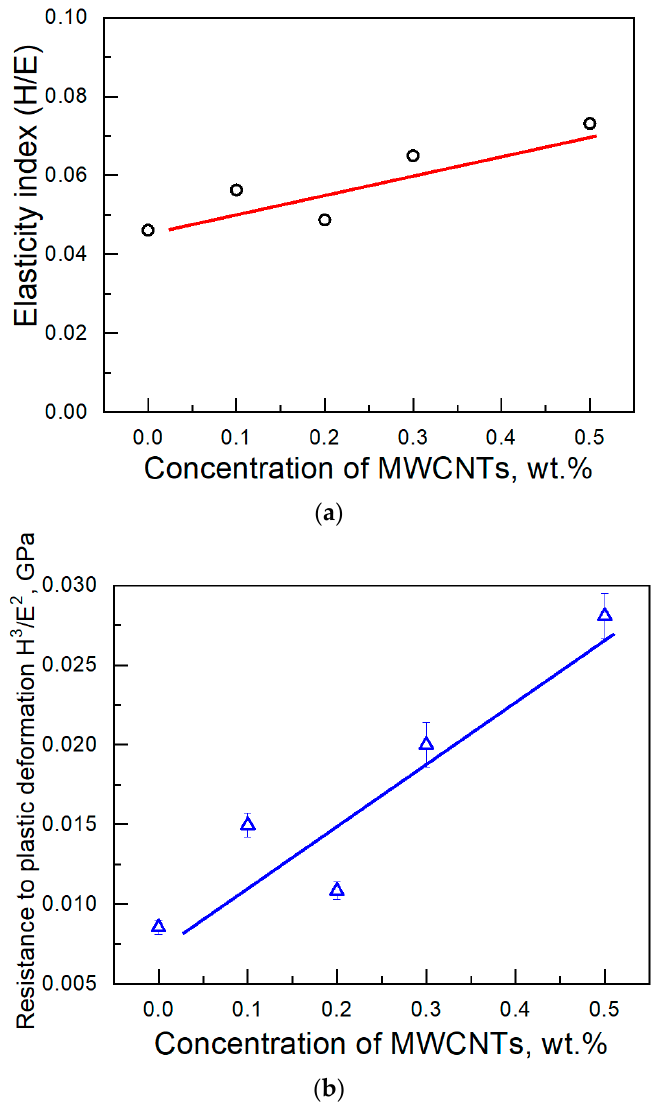
Figure 8. Elasticity index H/E ( a ) and elasticity resistance to plastic deformation H 3 /E 2 ( b ) vs. concentration of MWCNTs. Linear fittings of the experimental points are shown by lines.